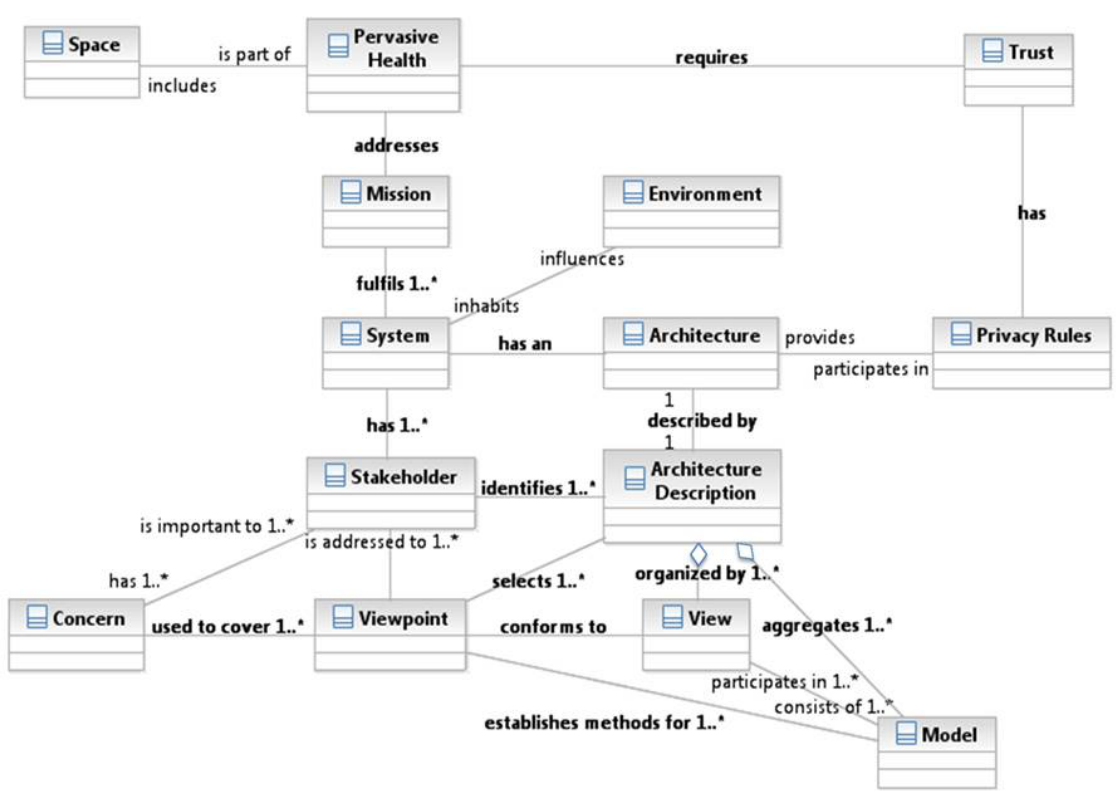
Figure 2. Conceptual framework for pervasive health.